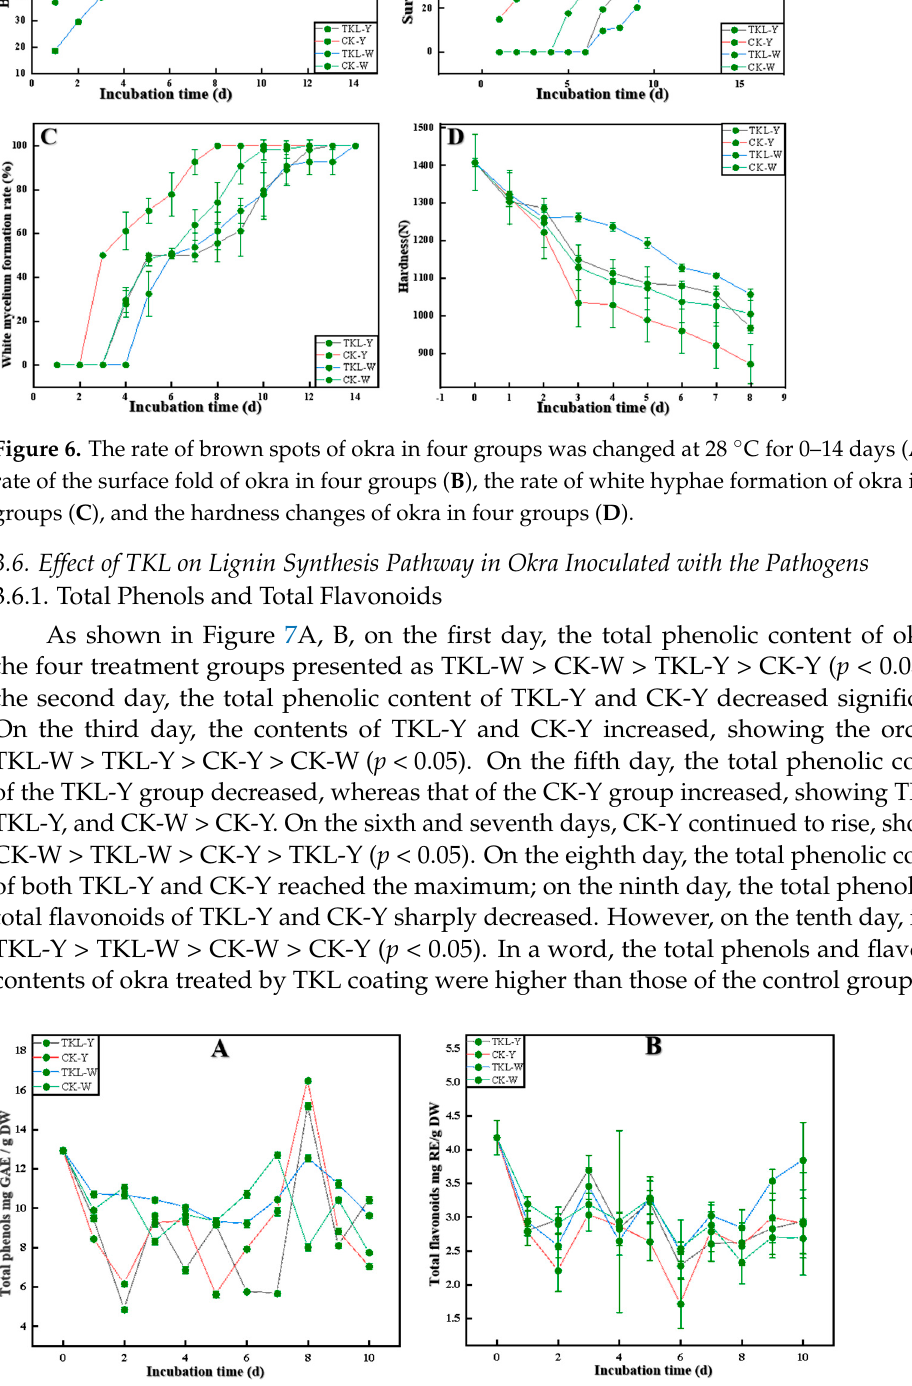
Figure 7. Total phenol content changes of okra in four groups at 28 ℃ for 0-10 days ( A ); total flavonoid content changes of okra in four groups ( B ).